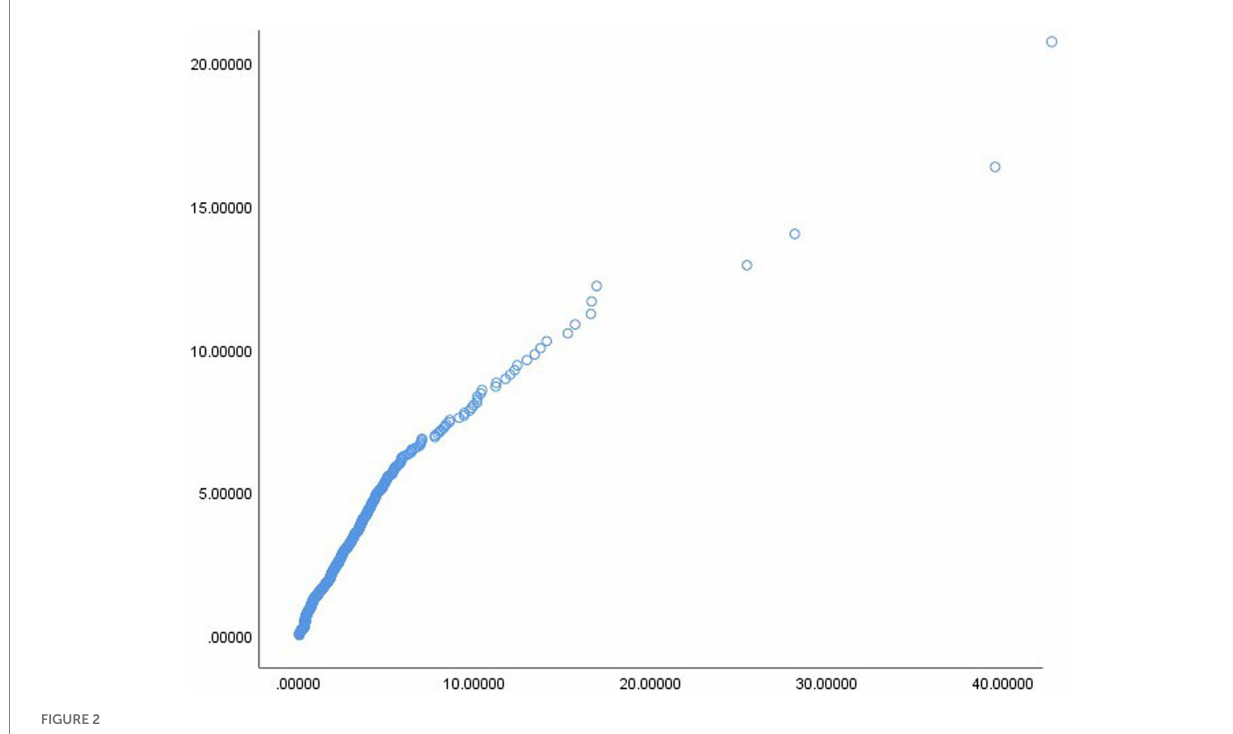
FIGURE 2 Chi-square and Mahalanobis distance